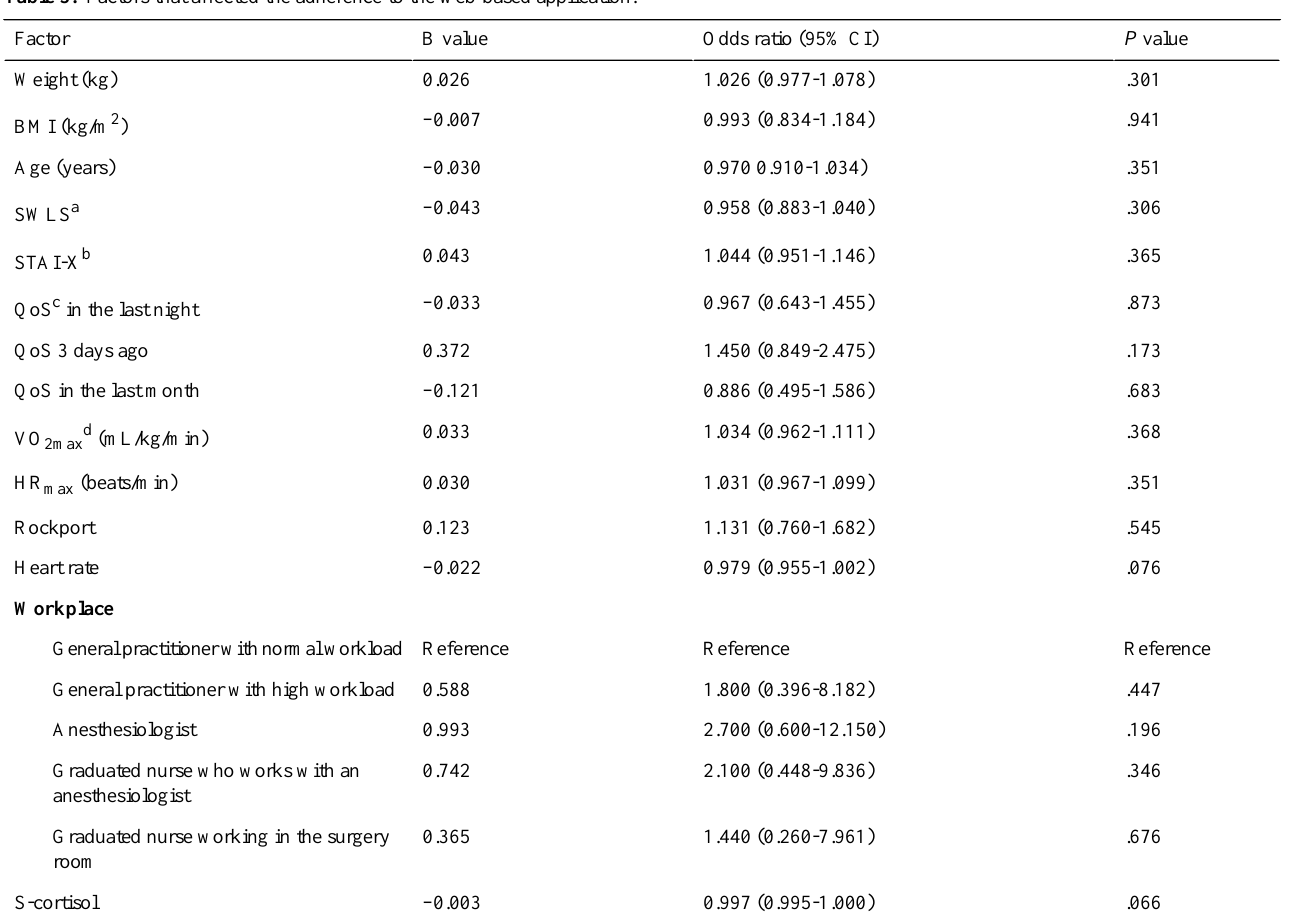
Table 3. Factors that affected the adherence to the web-based